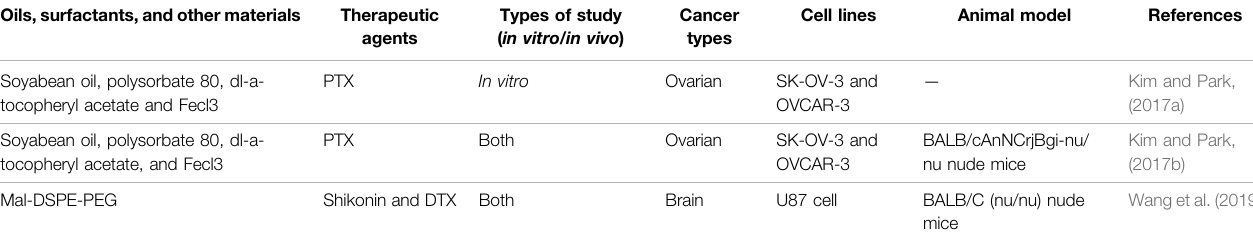
TABLE 5 | Examples of nanoemulsion-targeted CD44 cells.